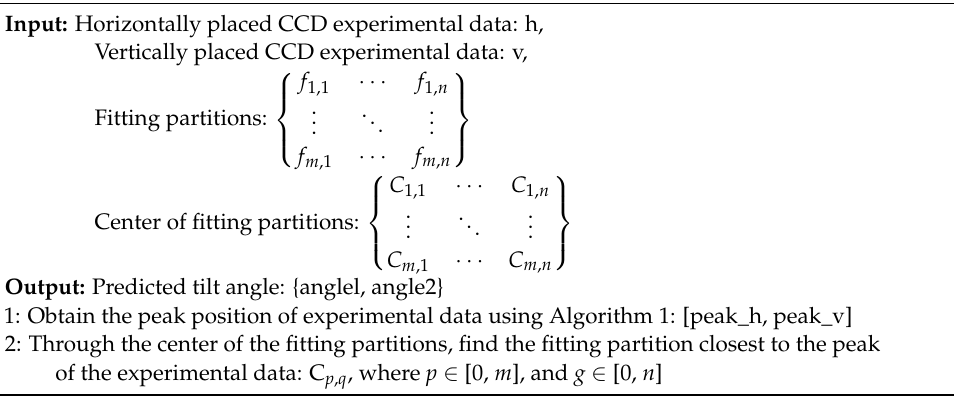
Algorithm 3. Use of the partition-fitting strategy to predict the tilt